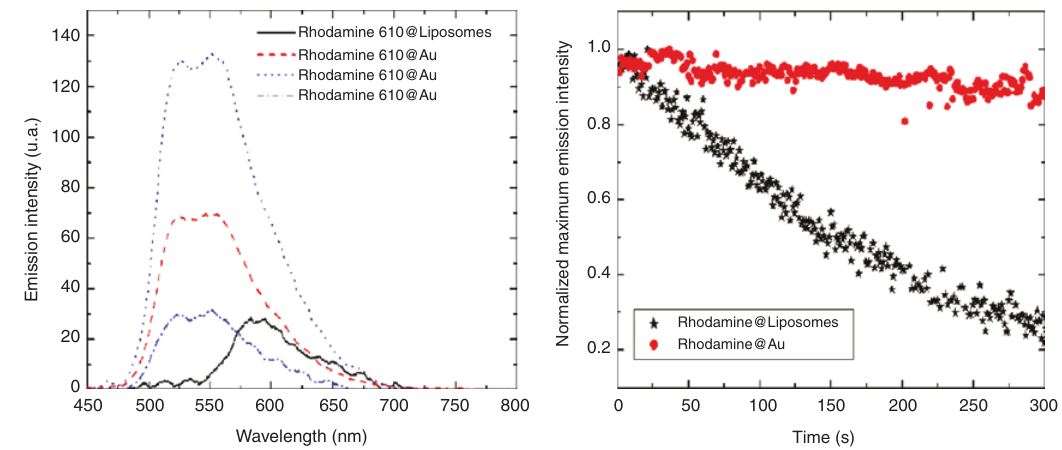
Figure 22: Left: Typical emission spectra of different rhodamine 610@Au nanoshells with water cores (dashed and dot curves) under the same excitation conditions. Black curve corresponds to the emission of rhodamine 610 in liposomes. Right: Fluorescence photoresistance of rhodamine 610 molecules encapsulated in Au nanoshell and liposomes. Adapted with permission from Ref. [98]. Copyright (2015) American Chemical